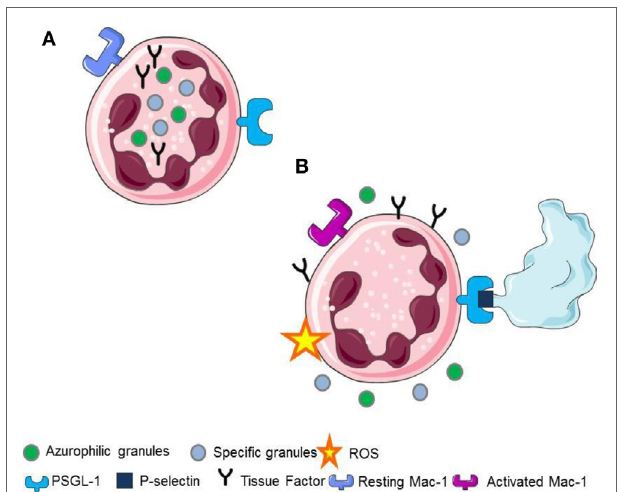
FiGURe 1 | (A) Resting neutrophils. (B) P-selectin recognizes PSGL1 promoting the generation of ROS, the activation of Mac-1 on neutrophils, the release of pentraxin 3 from the neutrophil-specific (secondary) granules, the release of myeloperoxidase from the neutrophil azurophilc (primary) granules and the surface expression, and the novo synthesis of tissue factor in